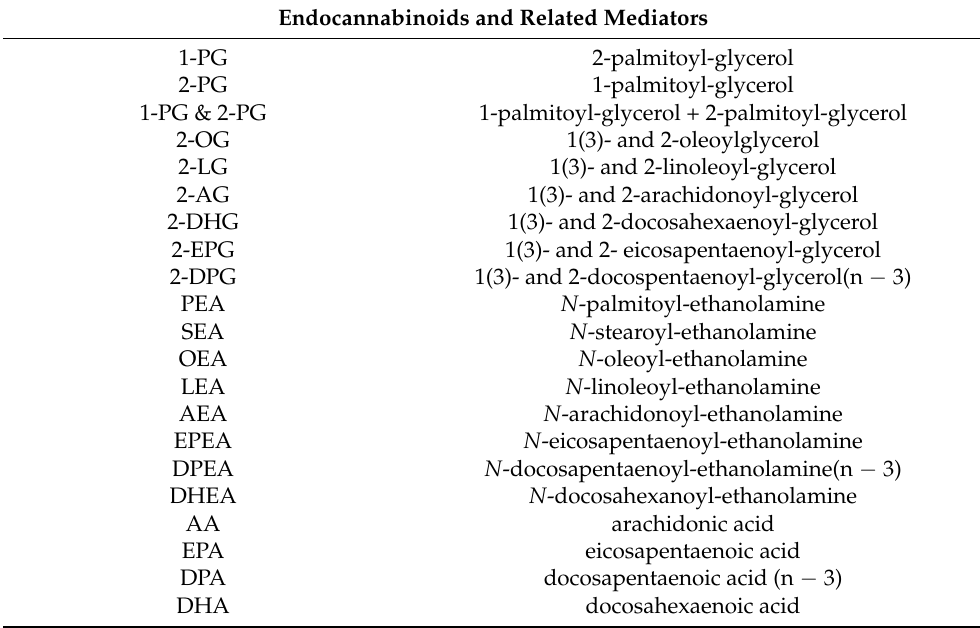
Table 1. Endocannabinoids and endocannabinoids-related congener’s